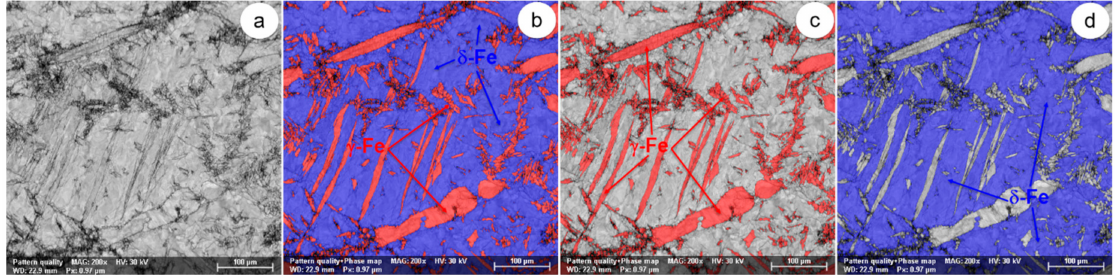
Figure 18. The SEM-EBSD composite images ( × 200) obtained after forging at 1300 ◦ C: ( a ) the microstructure of the analysed field; ( b ) the distribution of existing phases in the microstructure of the analysed field; ( c ) the distribution of the γ -Fe phase; ( d ) the distribution of the δ -Fe